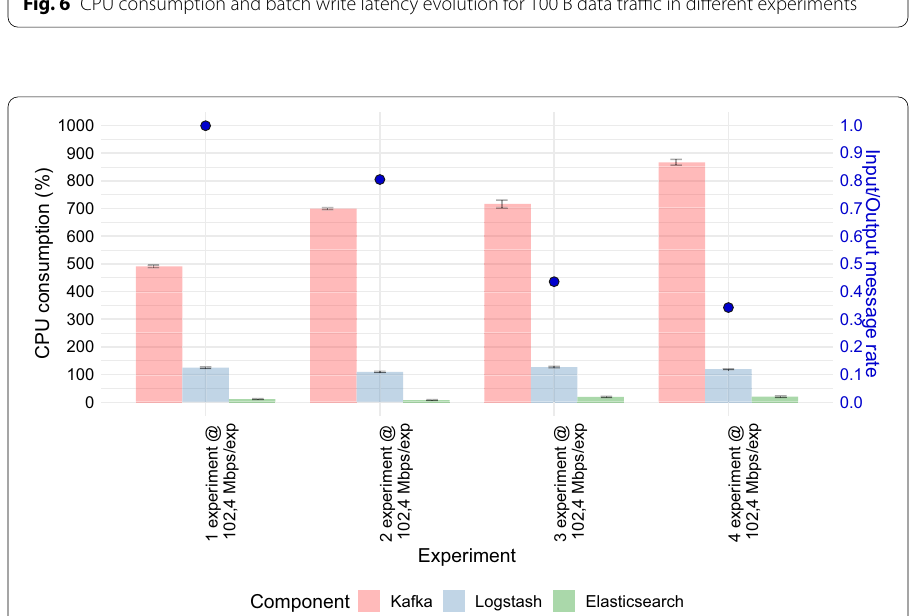
Fig. 7 CPU consumption and I/O message rate evolution for 100 B data traffic in different